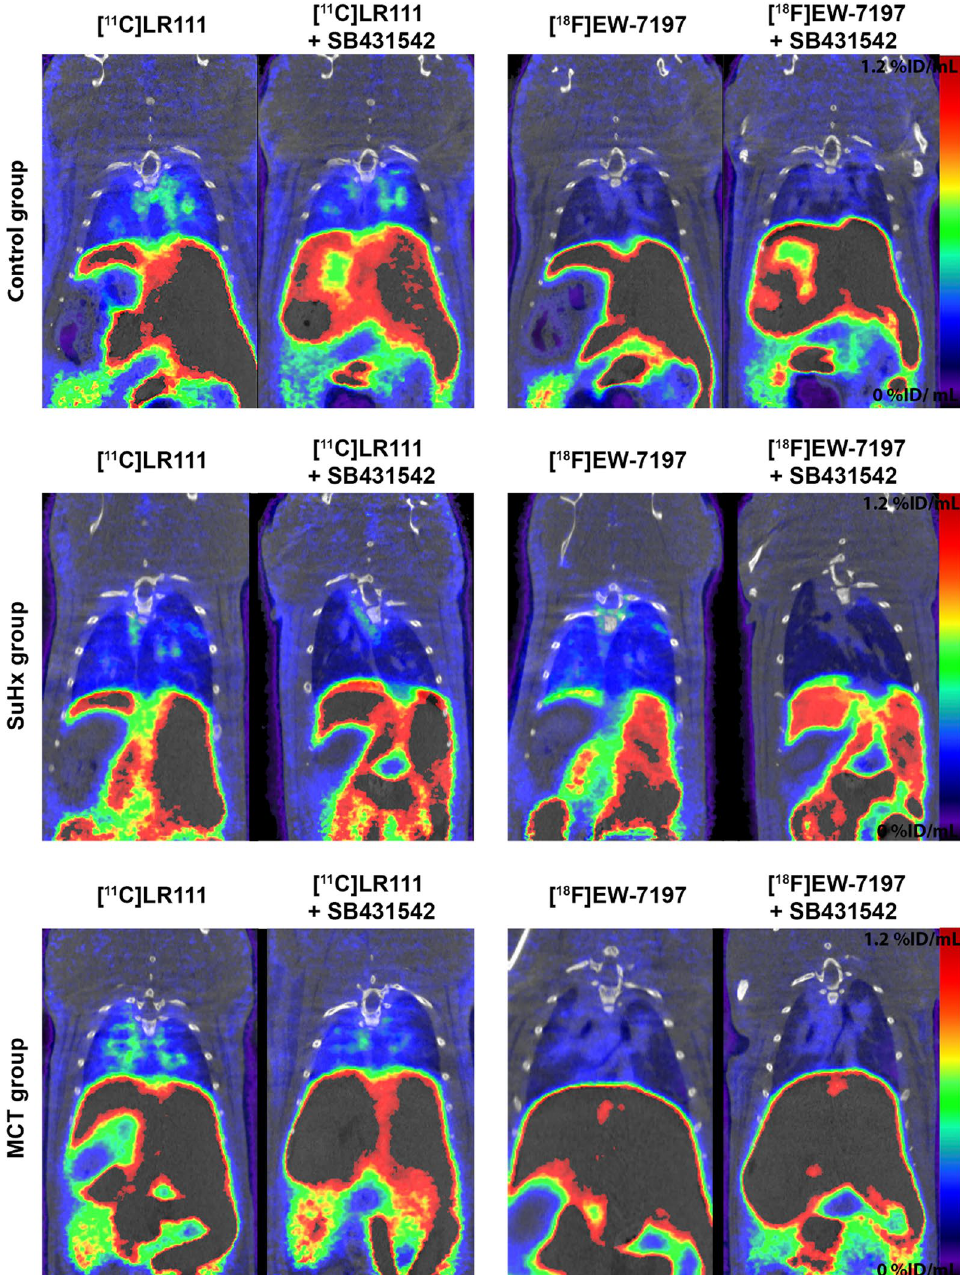
Fig. 9 Representative PET images of [ 18 F]EW-7197 and [ 11 C]LR111 in healthy rats, SuHx rats and MCT rats with and without